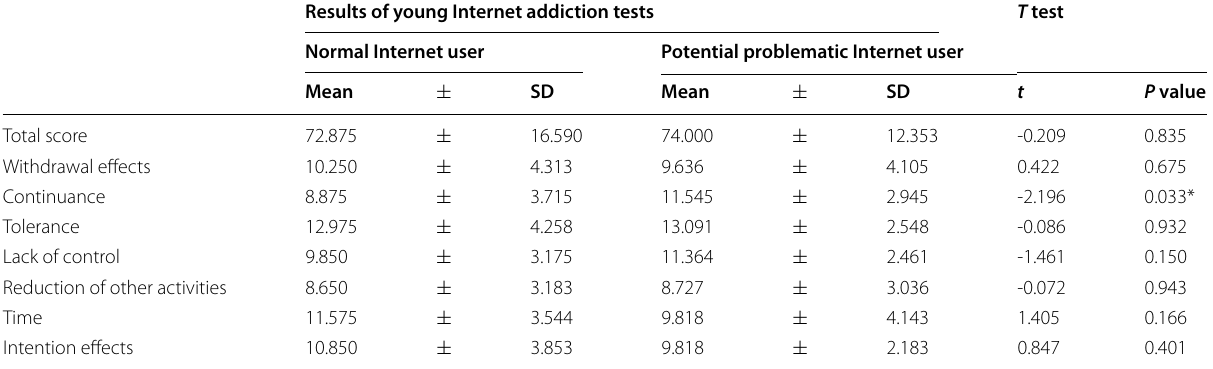
Table 8 Correlation between the different components of the “Exercise Dependence Scales‑21 Manual and the results of young Internet addiction test Results of young Internet addiction tests T test Normal Internet